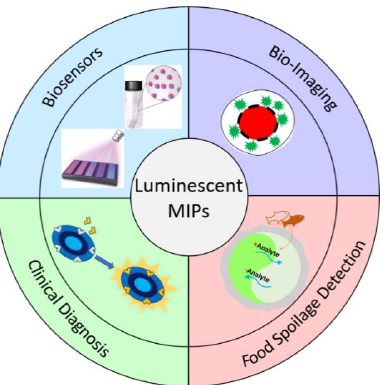
Figure 1. Schematic illustration of potential applications of luminescent MIPs.